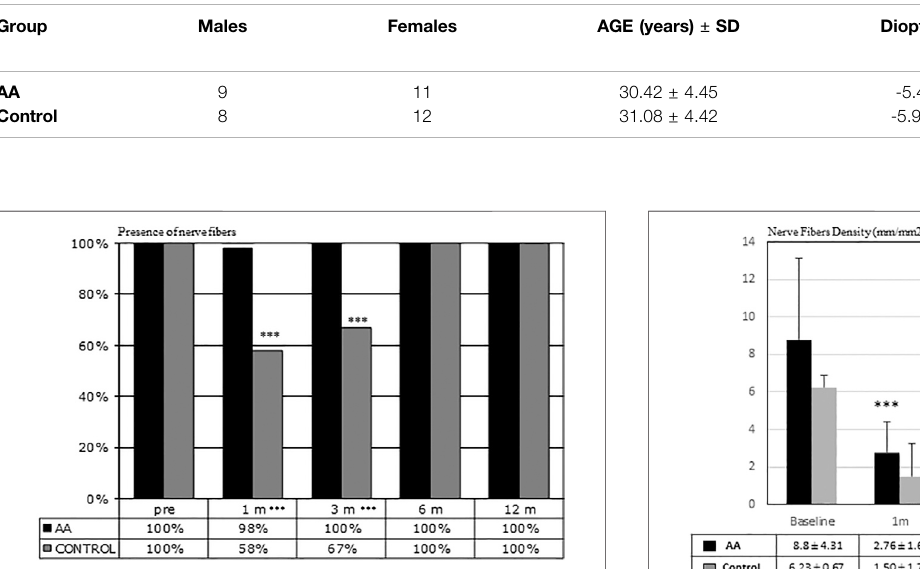
FIGURE 2 | Nerve Fibers Density ( μ m/mm 2 ) during follow-up. Nerve regeneration resulted to be signi fi cantly faster in patients treated with AA than in the control group (* p < 0.05; ** p < 0.01; *** p < 0.001 by Student ’ s